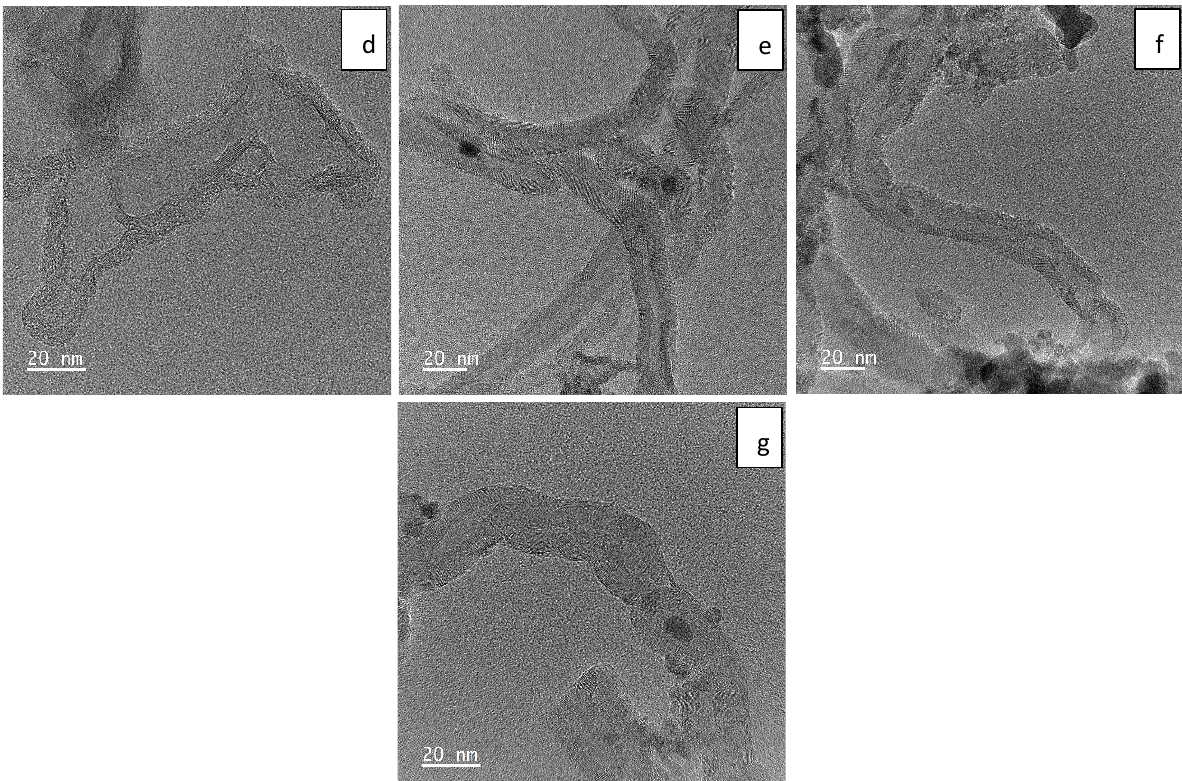
Figure 2. TEM image of ( a ) Ni(OH) 2 ; ( b ) Fe 2 O 3 ; ( c ) MnO 2 ; ( d ) CNTs; ( e ) Ni(OH) 2 -CNT; ( f ) Fe 2 O 3 -CNT; and ( g ) MnO 2 -CNT. Table 1. Elemental composition of the MOs and MO-CNT hybrids.